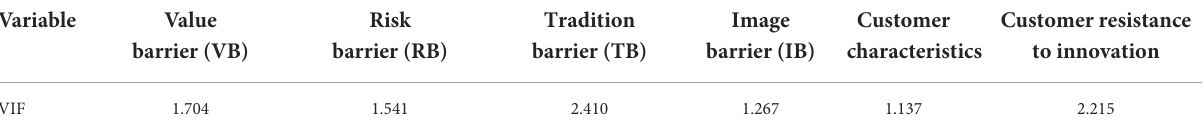
TABLE 1 Common method variance assessment via full collinearity estimate criteria.